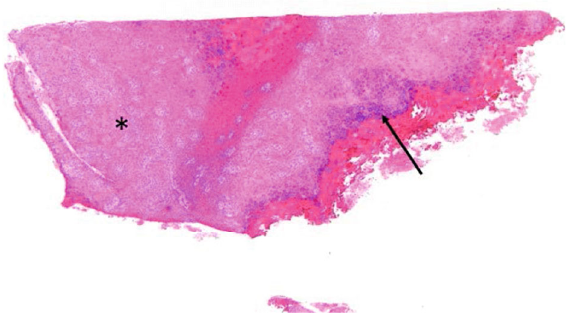
Figure 2: Conjunctival tarsal biopsy fragment showing acanthosis with epidermal hyperplasia (asterisk) and slight papillomatosis and hypergranulosis in super fi cial layers (arrow). Hematoxylin and Eosin, 4x magni fi